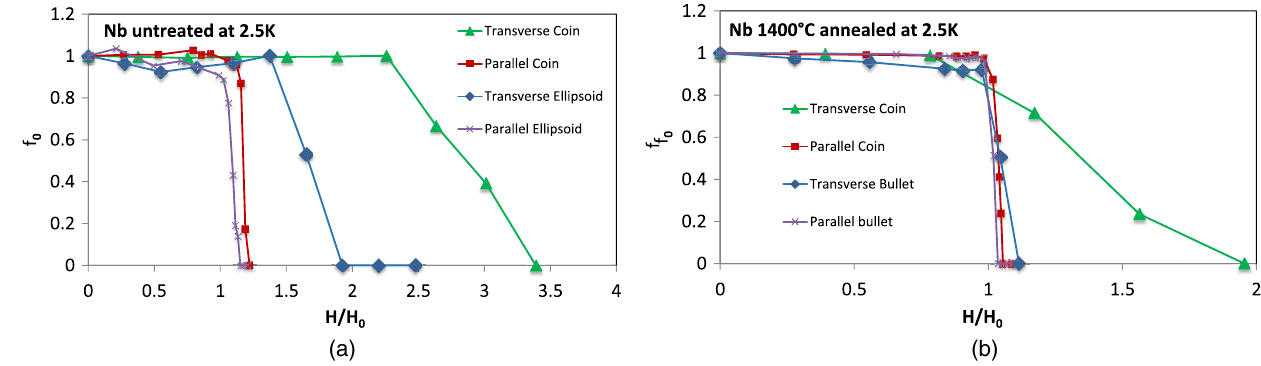
FIG. 11. Fit parameter f 0 signifying the volume fraction probed by the muons which is in the field free Meissner state as a function of applied field in four geometries. (a) Chemically etched samples with no heat treatment: The apparent differences in H=H 0 are correlated to the different sensitivity to pinning of the four geometries. (b) Annealing at 1400 °C virtually releases all